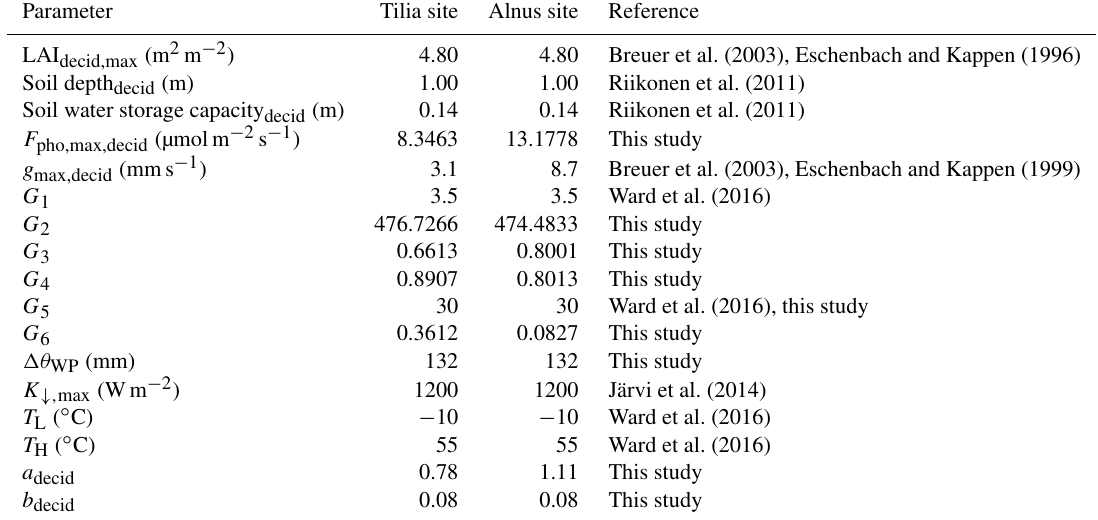
Figure 2. The fitted dependencies of the surface conductance on environmental factors for the (a) incoming short-wave radiation K ↓ , (b) specific humidity deficit (cid:49)q , (c) air temperature T air , and (d) soil moisture deficit (cid:49)θ in SUEWS separately for Tilia (solid black line) and Alnus (dashed red line) trees. Table 2. SUEWS parameters used to simulate photosynthesis, respiration, and transpiration of the studied street trees. Parameter Tilia site Alnus